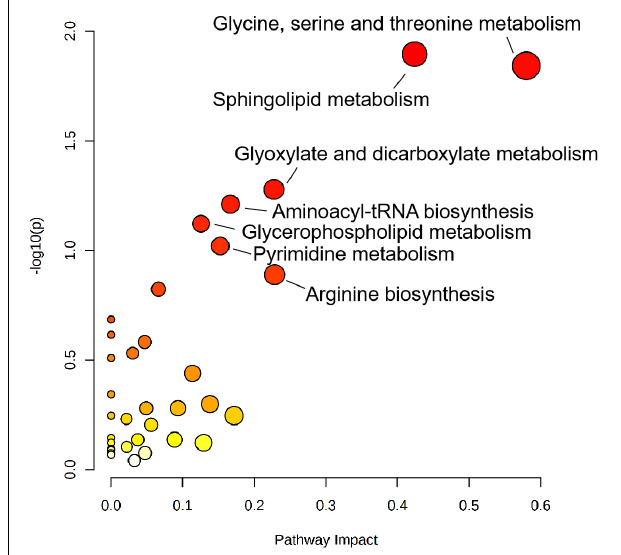
FIGURE 4 | Metabolic pathway analysis results related to differential metabolites between PE and non-PE neonates, presented by bubble plots. Each bubble represents a metabolic pathway. The x -axis of the bubble and its size represent the impact factors of the path in topology analysis. The y -axis of the bubble and its color represent the p -value of enrichment analysis [represented by the negative natural logarithm, -ln(P)]. The color intensity reflects the corresponding p -value and the enrichment